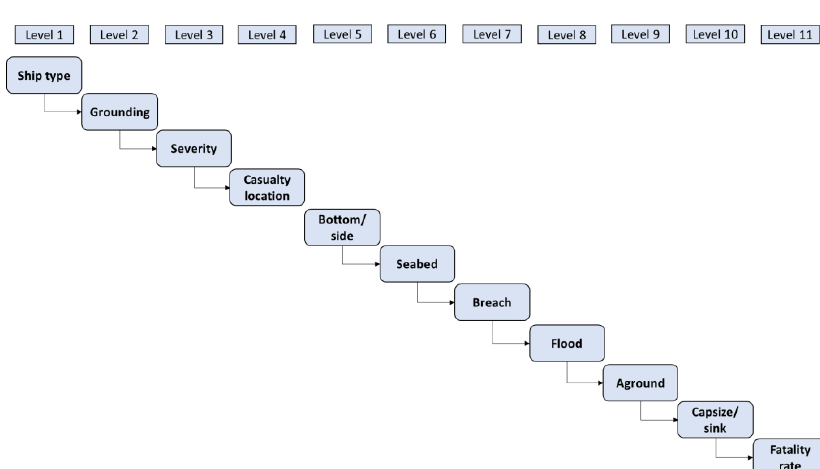
extent’ and ‘consequences’ in terms of fatalities corresponding to slow and fast sinking is updated with relevant developments in FLARE related to new damage breach distribu- tions and ensuing direct assessments using verified numerical tools. A brief explanation of the different nodes is provided next. 4.1.1. Level 1: Ship Type The first node in the risk model is assigned to ship type to distinguish the risk model for two types of passenger ships, namely Cruise ship and RoPax. Presently, the category ‘Cruise’ includes Cruise and Pure passenger ships, whereas ‘RoPax’ includes RoRo pas- senger ships and Rail. 4.1.2. Level 2: Accident Type In the development of any risk model, in accordance with IMO FSA, the identification of hazards leading to ship flooding is the initial step in the risk model. In this respect, three hazards are considered, namely collision, side grounding and bottom grounding. Side and bottom groundings are considered as a single node (level 5: bottom/side in Fig- ure 12) in the grounding risk model, which again could be further differentiated based on results from pertinent numerical simulations. 4.1.3. Level 3: Severity For a given hazard and ship type, the severity of the accident is addressed in the form of the node ‘severity’. In general, five potential classes of severity can be identified, as shown in Figure 13. In the risk model, stages 1 and 2 (incident and non-serious) have been grouped into ‘non serious’, and stages 3, 4 and 5 (serio us, flood and sink) into ‘serious’ category as only ‘serious’ accidents are considered in project FLARE for risk assessment.